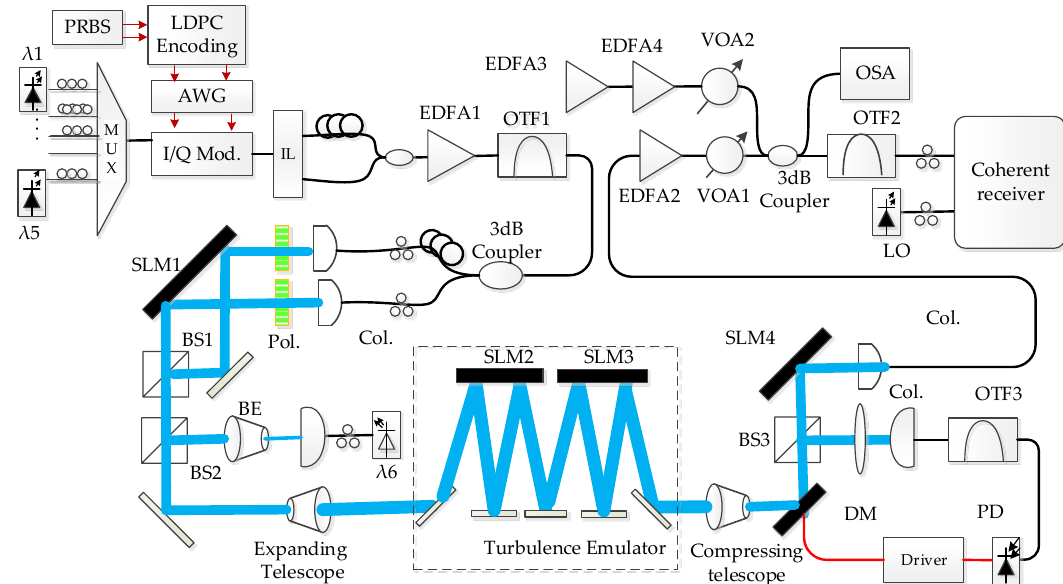
Figure 1. Experimental setup for adaptive optics (AO) enabled free-space optical (FSO) communication system .